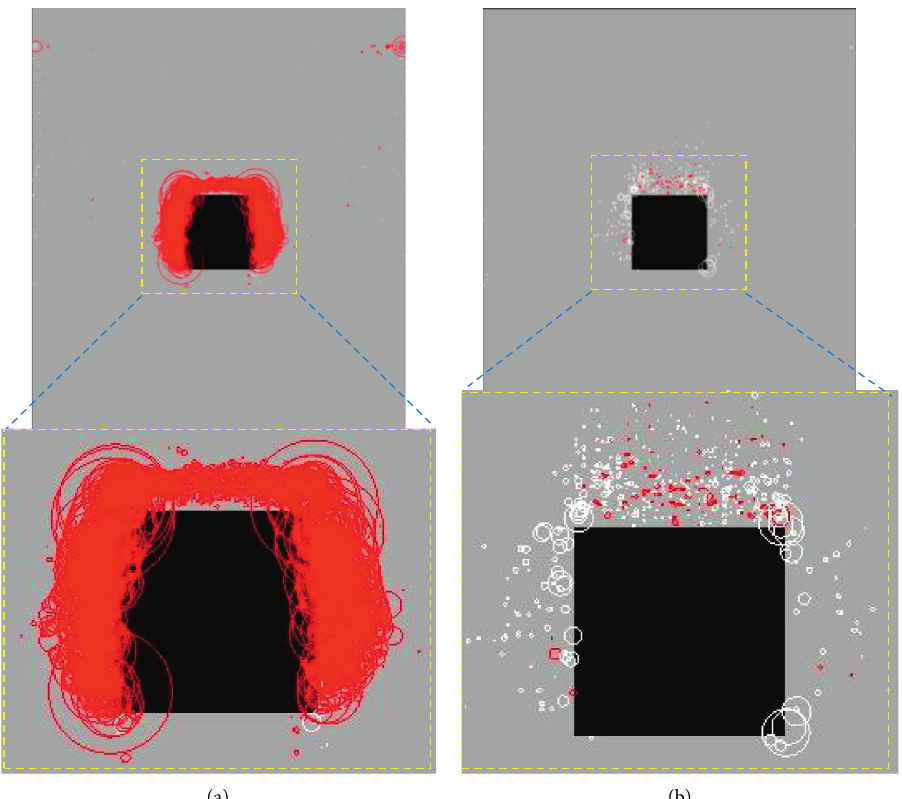
Figure 6: AE distribution around the underground chamber in the two numerical models. (a) Numerical model without bolt. (b) Numerical model with